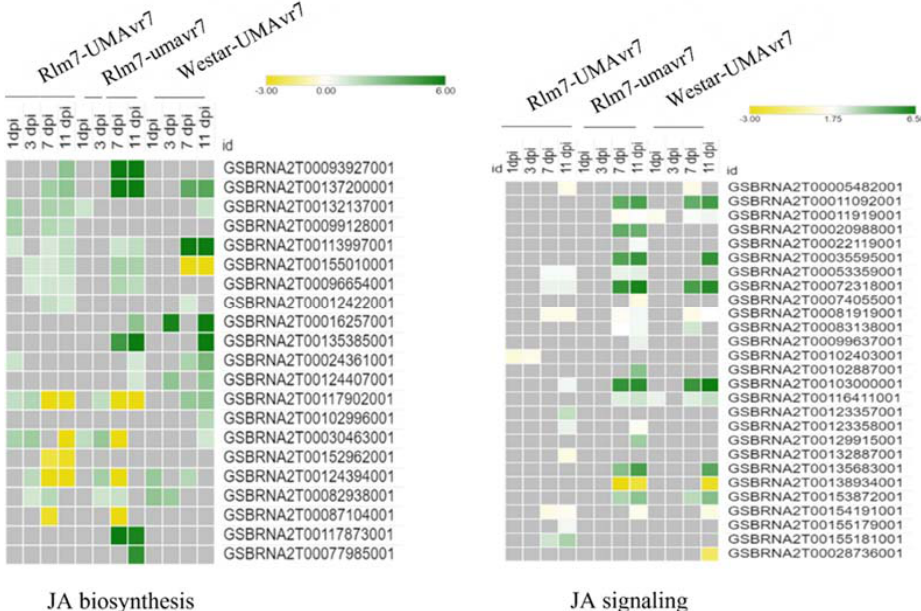
Figure 12. Differential expression of genes related to Jasmonic acid biosynthesis and signaling pathways. Rlm7-umavr7, Rlm7-umavr7, and Westar-UMAvr7 interactions are shown. Logarithm of ab ‐ solute value of the fold ‐ change cutoff (logFC) ≥ 2, and false discovery rate (FDR) ≤ 0.05.